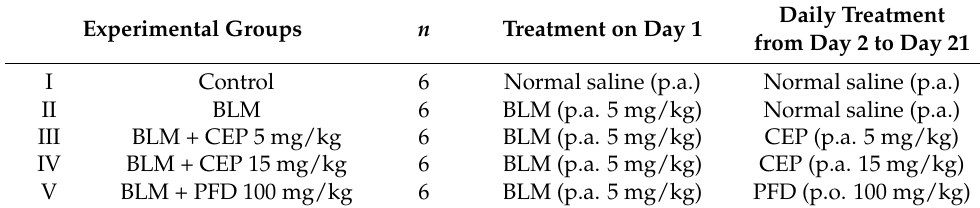
Table 4. Scheme of treatment.